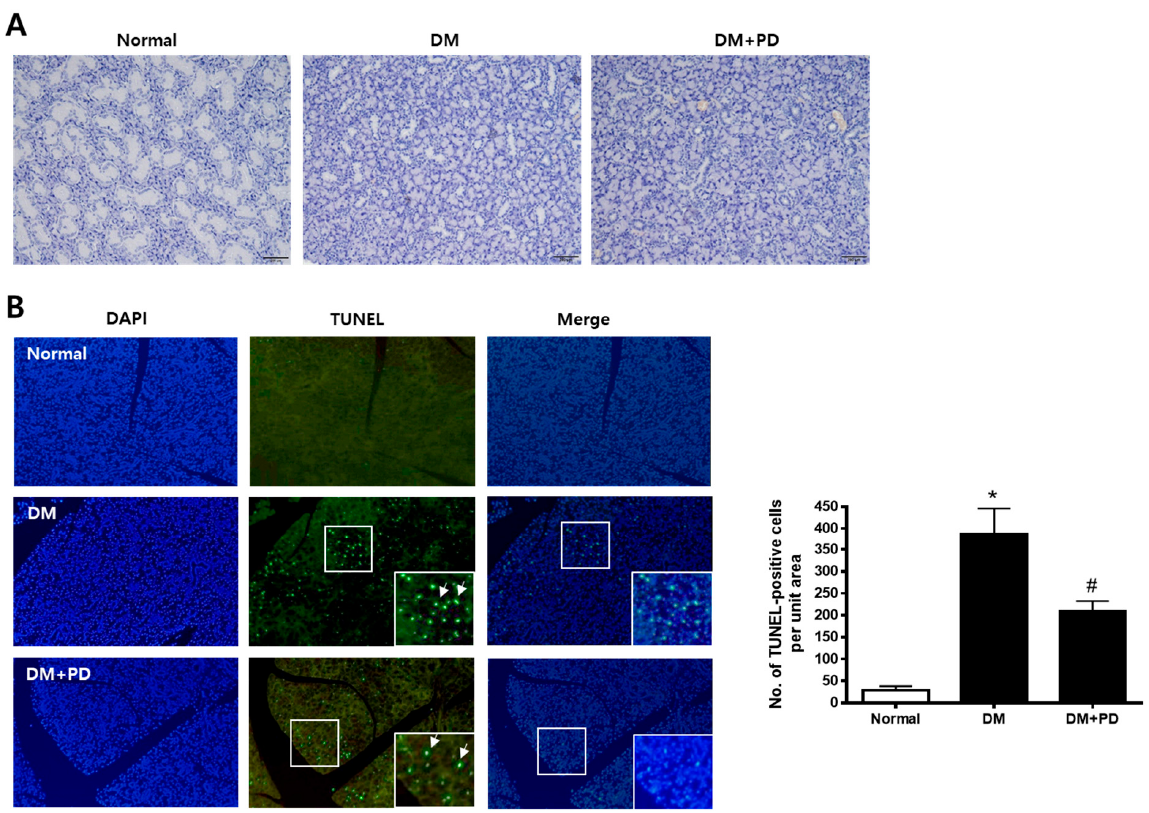
Figure 3. Effect of polydatin on histological changes and apoptosis in submandibular glands. ( A ) Histological analysis of the submandibular gland was performed and images of H&E staining are presented. ( B ) TUNEL staining is presented. Arrows indicate TUNEL-positive cells. Data are presented as the mean ± standard deviation ( n = 7). * p < 0.05 vs. Normal group; # p < 0.05 vs. DM group.